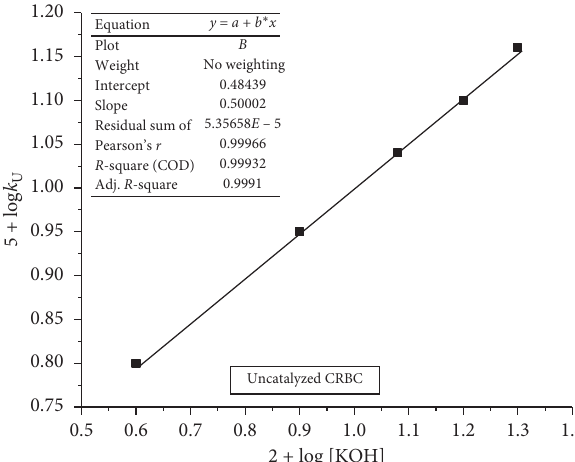
Figure 8: Plot of (4+log k